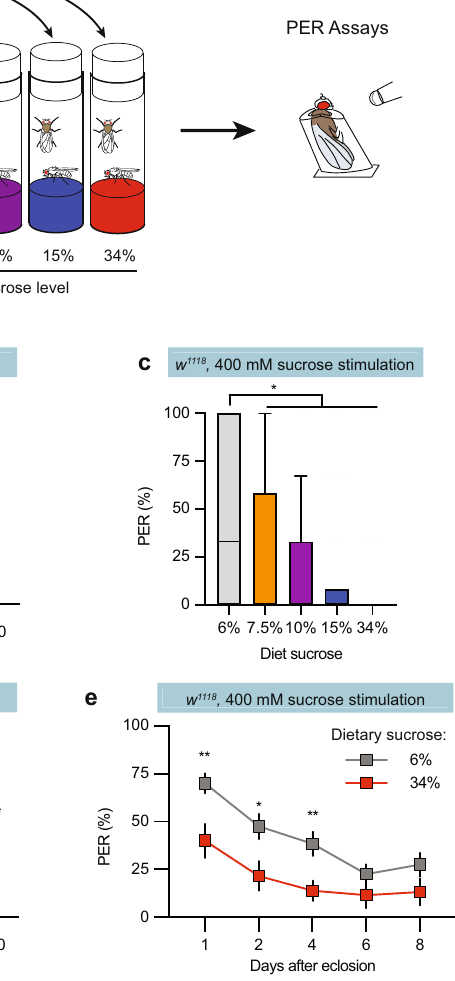
Fig. 1 | Regulation of sweet taste responses by dietary sugar. a Experimental procedure schematic. Newly eclosed fl ies were shifted to diets supplemented with various levels of sucrose. Proboscis Extension Response (PER) assays were per- formed four days later. b Plot of sugar-evoked PER in w 1118 males reared on the indicated diets (colour-coded). The y-axis shows PER %. The x-axis shows sucrose concentration in the stimulation solution. c Box plot showing the PER response to 400mM sucrose stimulation of male fl ies fed the indicated sugar diets. Median